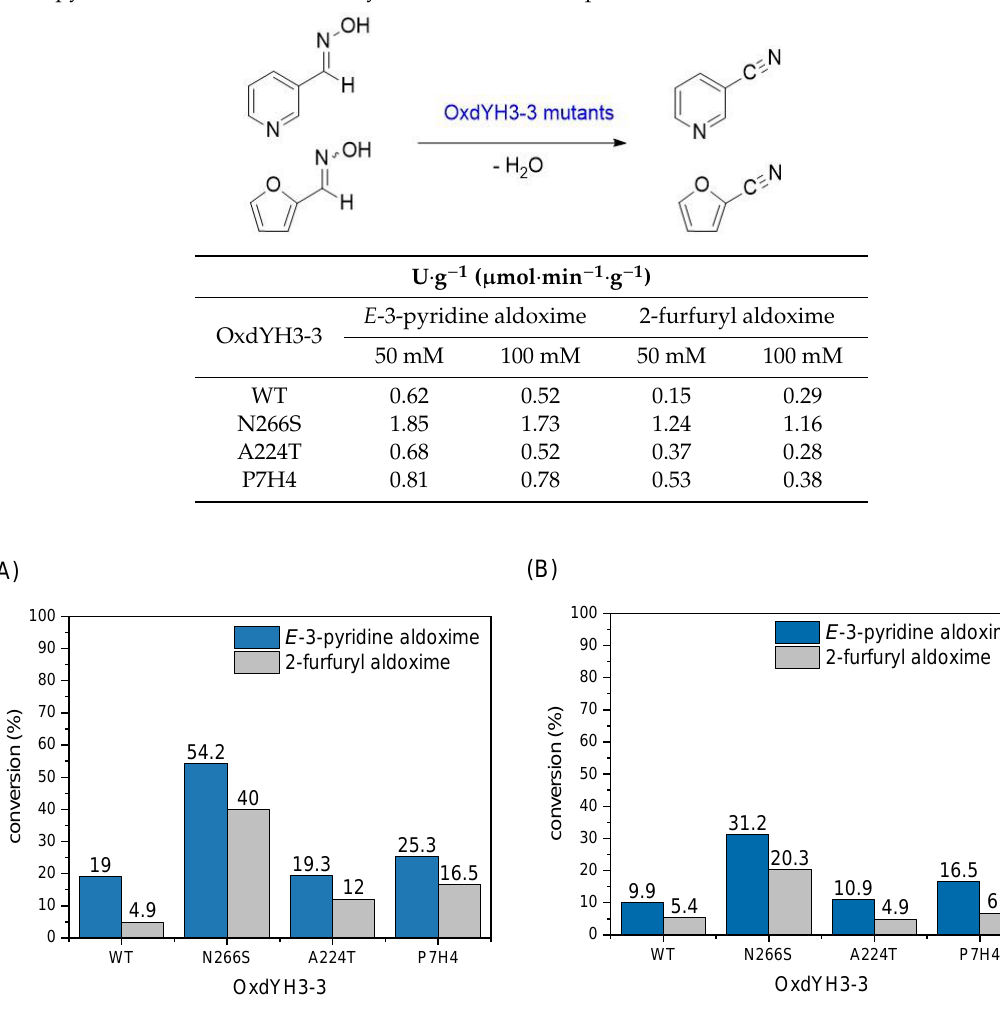
Figure 3. Biotransformations of OxdYH3-3 WT and mutants (1 h) at 50 mM ( A ) and 100 mM ( B ) of substrate concentration.